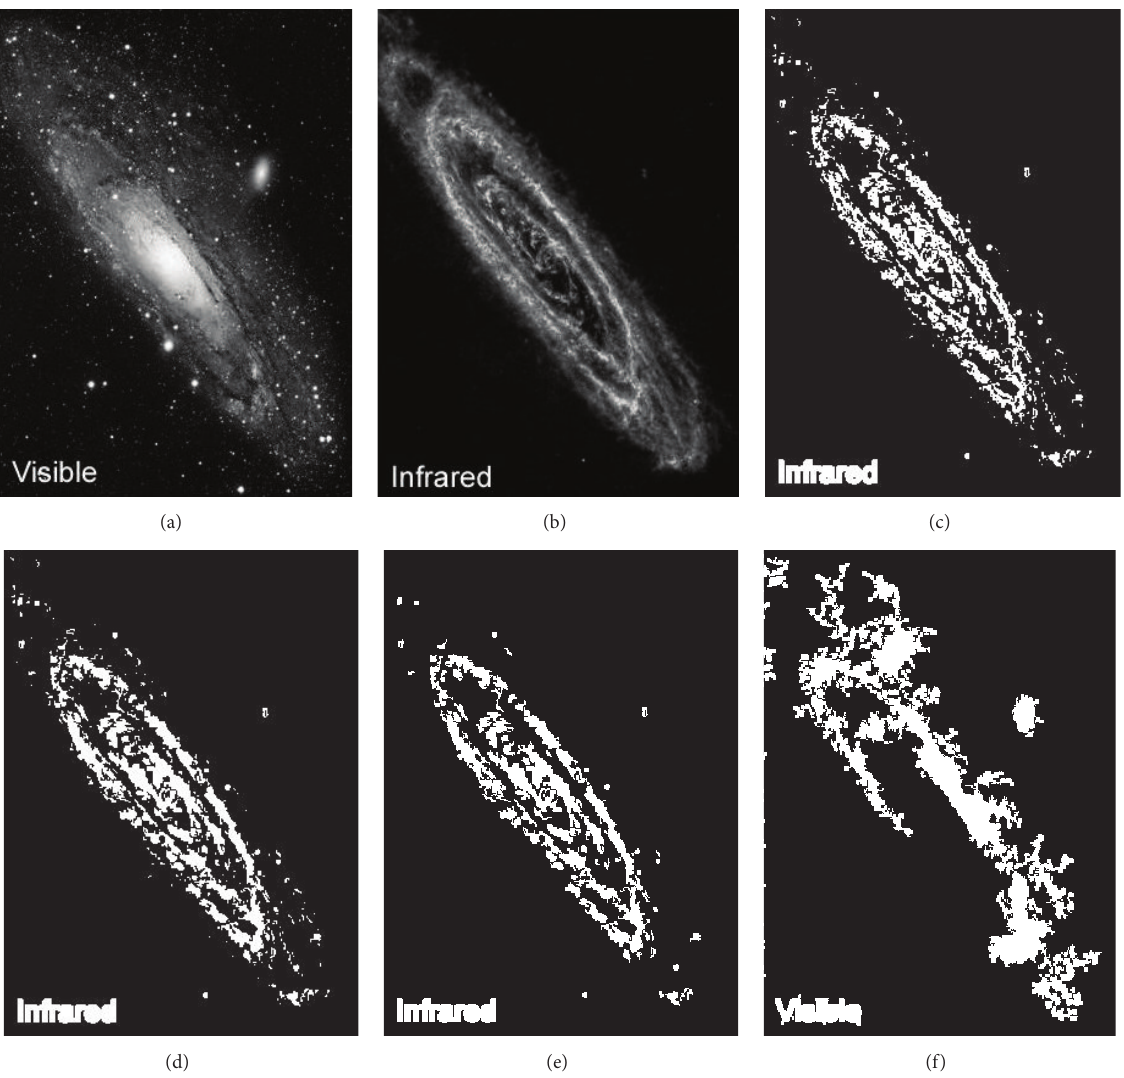
Figure 2: Andromeda galaxy (M31): (a) visible image, (b) IR image, (c) local variance image, (d) distance image, (e) IR segmented image, and (f) visual segmented